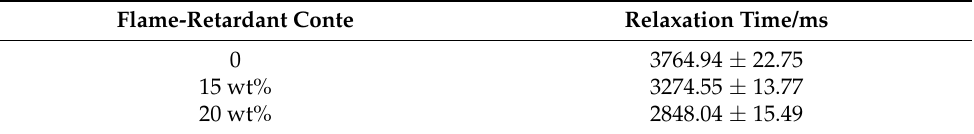
Figure 9. Low-field NMR spectra of TPU/PLA composites with different flame-retardant contents. Table 3. Peak areas of the blends corresponding to relaxation times.